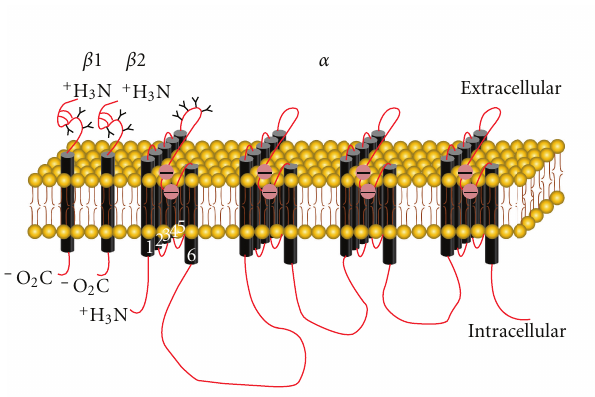
Figure 1: Structure and localization of glycosylation sites of VGSC. The primary structures of the subunits of the voltage-gated ion channels are illustrated as transmembrane-folding diagrams. Cylinders represent probable α -helical segments. Bold lines in red represent the polypeptide chains of each subunit, with length approximately proportional to the number of amino acid residues in the brain sodium channel subtypes. The extracellular domains of the β 1 and β 2 subunits are shown as immunoglobulin-like folds. Sites of probable N-linked glycosylation; open circle with “—”, amino residues that form the ion selectivity filter and tetrodotoxin binding